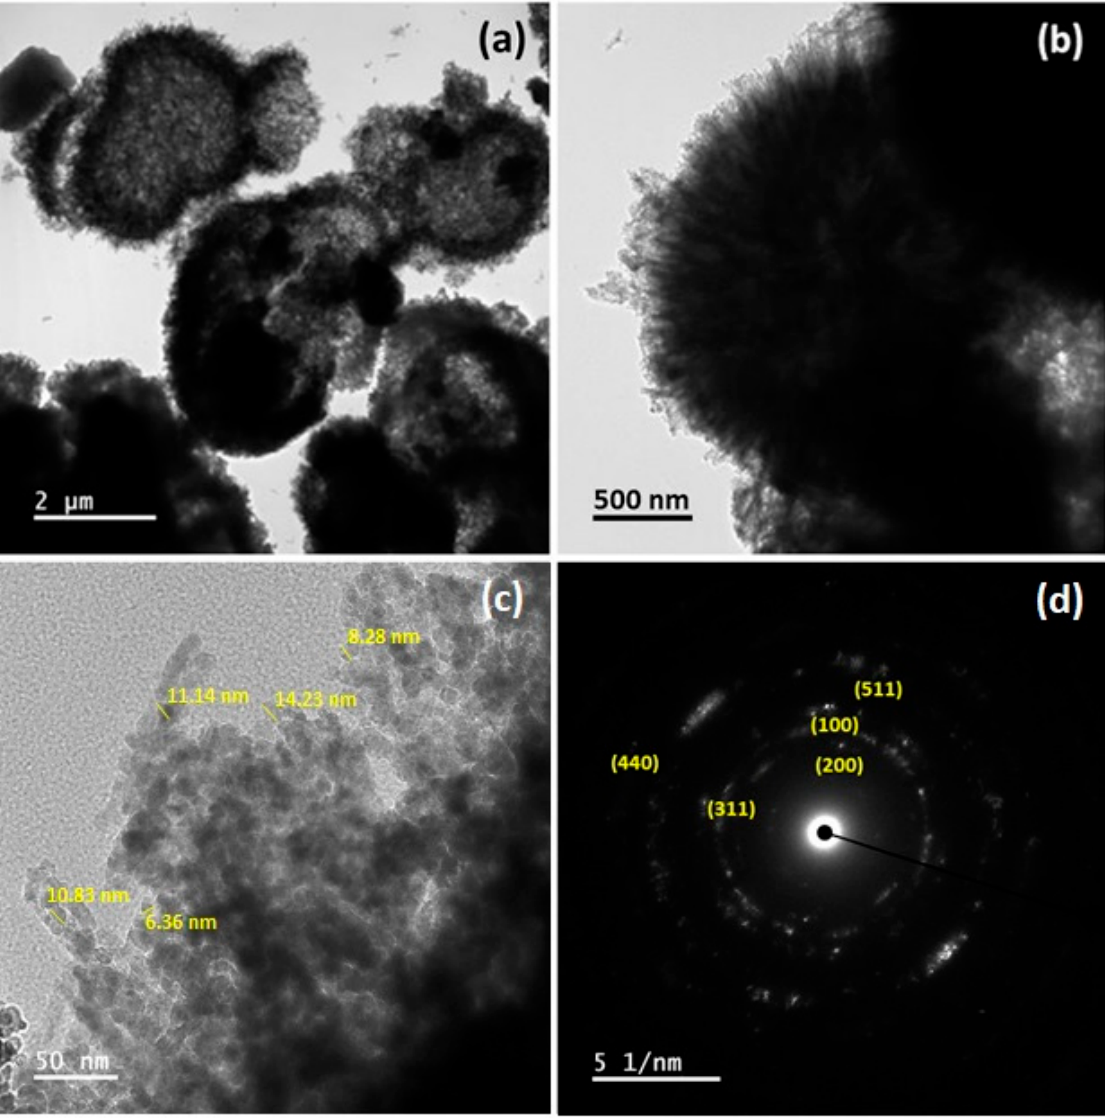
Figure 5. ( a – c ) Transmission electron microscopy (TEM) images at different magnifications and ( d ) selected area electron diffraction (SAED) pattern of Ni 10 /NCO/RGO hybrid